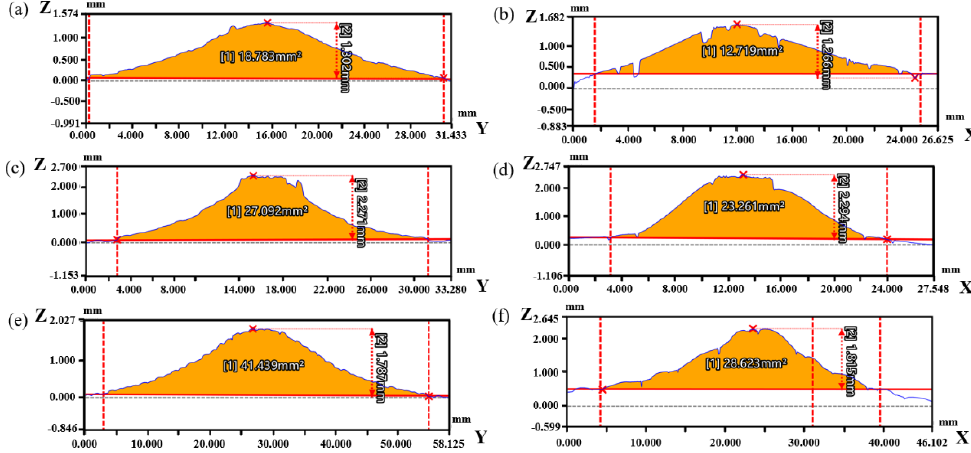
Figure 12. Cross-sectional diagram of representative shooting points in PP: ( a ) Y – Z cross section of sample I; ( b ) X – Z cross section of sample I; ( c ) Y – Z cross section of sample II; ( d ) X – Z cross section of sample II; ( e ) Y – Z cross section of sample III; ( f ) X – Z cross section of sample III.